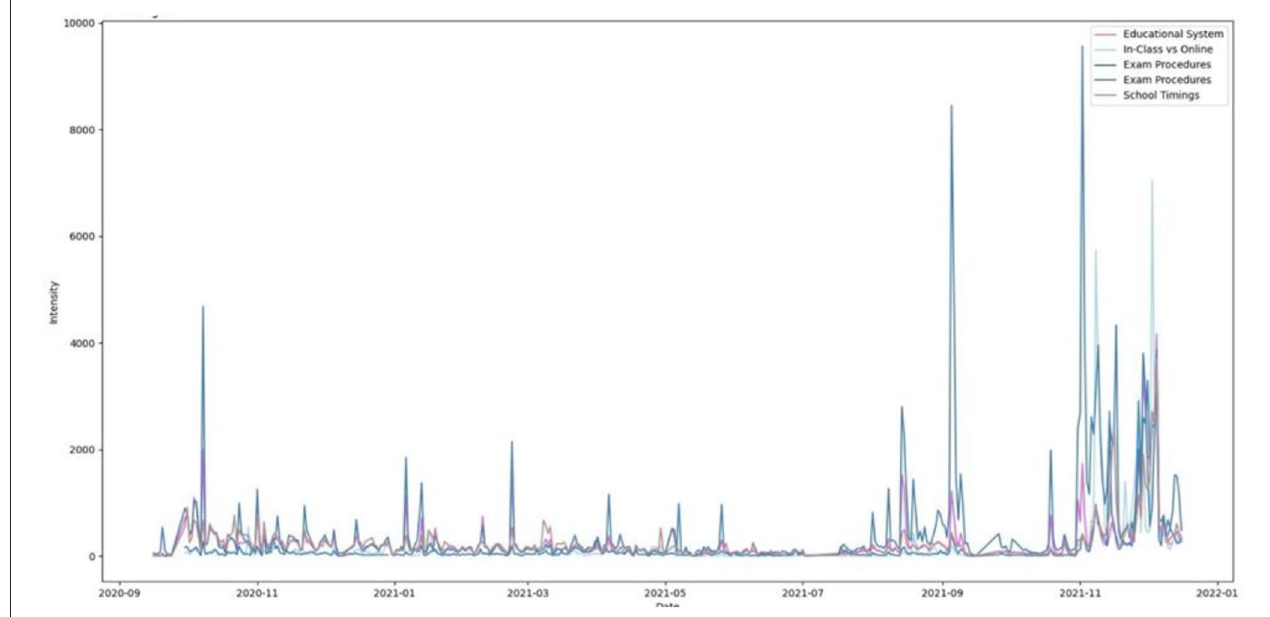
FIGURE 7 | Temporal progression of parameters (macro-parameter: